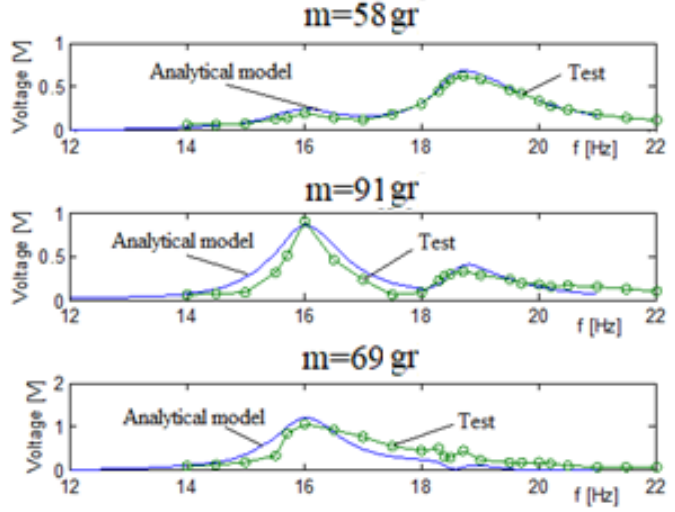
Figure 12. Three bimorphs system output voltage (series electrical connection)—experimental results vs analytical predictions. Table 5. Experimental results vs. analytical predictions (series electrical connection)—the three bimorphs system.